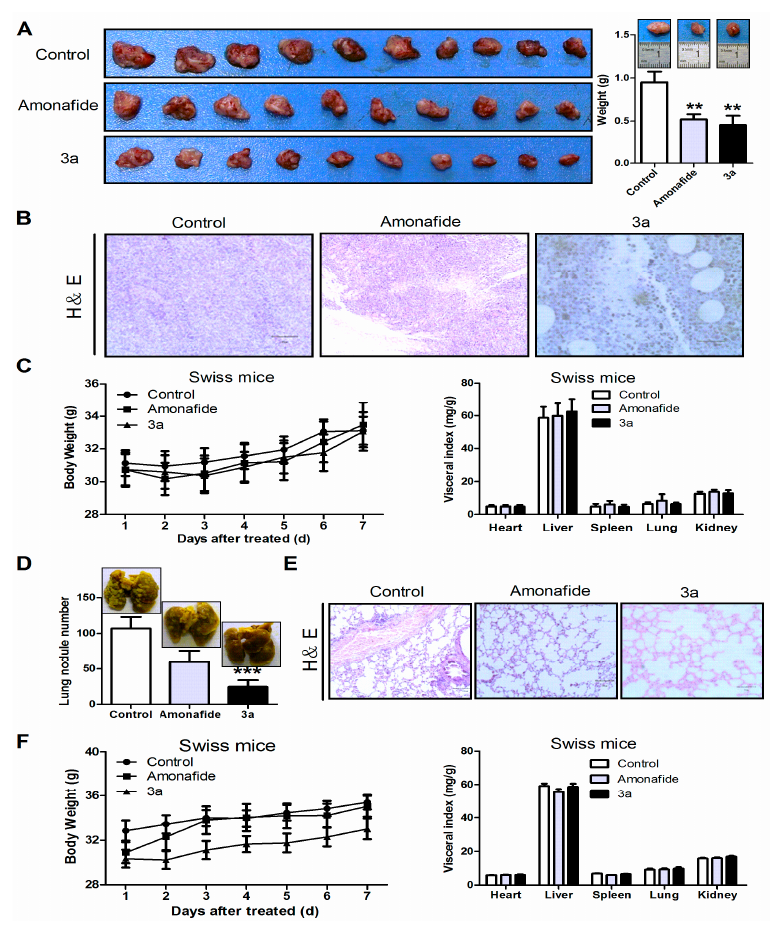
Figure 2. Antitumor activity of compound 3a was evaluated in vivo. ( A ) Photographs of tumor obtained from each treatment group excised on day 10. ( n = 3, x ± SD, ** p < 0.01) (left); Mean tumor weight with representative photo correspondingly (right); ( B ) Representative photograph of histological section was obtained from each treatment group excised on day 10 (HE stain, 20×). The scale bar represents 100 µm; ( C ) The changes of body weight of mice treated with 3a , amonafide, and normal saline. Visceral indexes (heart, liver, spleen, lung and kidney) were evaluated after treatment in with 3a , amonafide, and normal saline; ( D ) Lung metastasis nodules numbers for pulmonary metastasis in mice treatment with 3a , amonafide, and normal saline. ( n = 3, x ± SD, *** p < 0.001); ( E ) Representative photograph of histological section was obtained from each treatment group excised on day 10 (H & E staining, 20×); ( F ) The changes of body weight of mice treated with 3a , amonafide, and normal saline. Visceral indexes (heart, liver, spleen, lung and kidney) were evaluated after treatment in with 3a , amonafide, and normal saline.